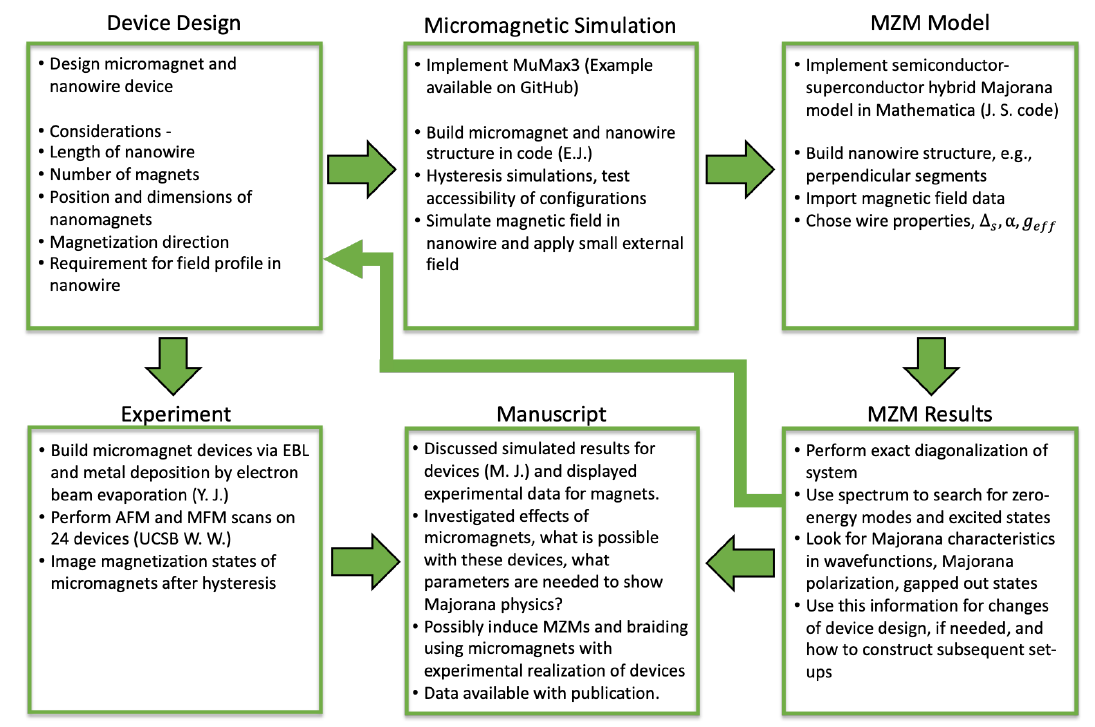
Figure 19: Study design, Volume and Duration of study. The bulk of the this work was carried out over nine months to find an appropriate micromagnet and nanowire set-up that demonstrated MZMs in the hybrid model. Approximately 5 different sin- gle Dragonfly configurations were tested and simulated, which was then used to construct the double Dragonfly and the T-junction. There were around 10 different designs tested for the double Dragonfly and T-junction. The experimental data was collected on a single chip where 24 devices had AFM and MFM measurements taken after an hysteresis cycle was applied to magnetize the